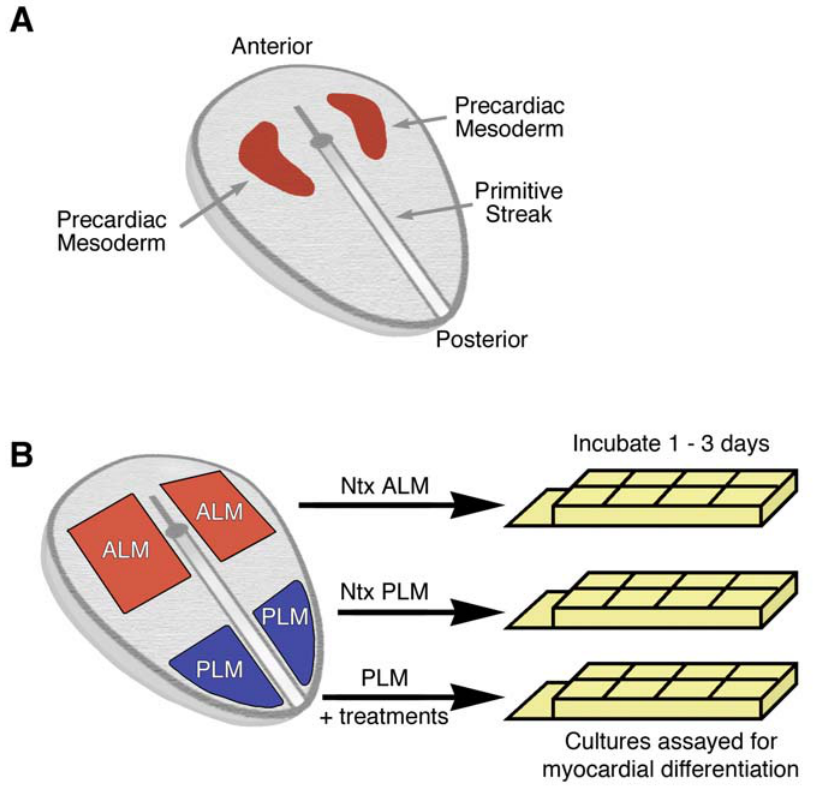
FIGURE 5 . Cardiac tissue formation in explants of avian tissue. (A) Representation of a HH stage 5 chick embryo shown from the dorsal side, with the location of the bilateral precardiac mesodermal fields depicted in red. At this stage of development, precardiac areas are comprised of nondifferentiated cells that have not begun to express cardiac-associated markers. (B) The positions of anterior and posterior lateral mesoderm (ALM and PLM) regions used as a source of tissue explants are illustrated in this diagram of an HH stage 5 chick embryo. ALM, but not PLM tissue, will spontaneously form contractile tissue when incubated in culture. The PLM tissue, which does not contribute cells to the heart in situ , is commonly used as a source of noncardiac mesoderm in cardiac induction